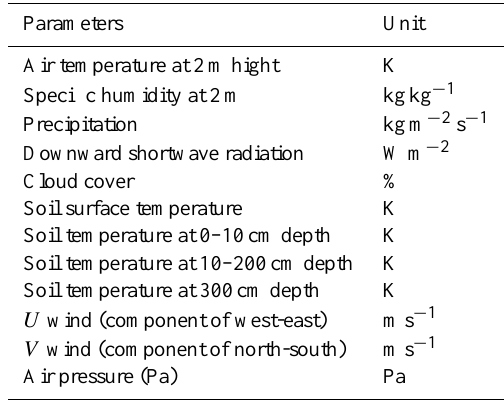
Table 3. Climate parameters from NCEP/NCAR used in the VISIT